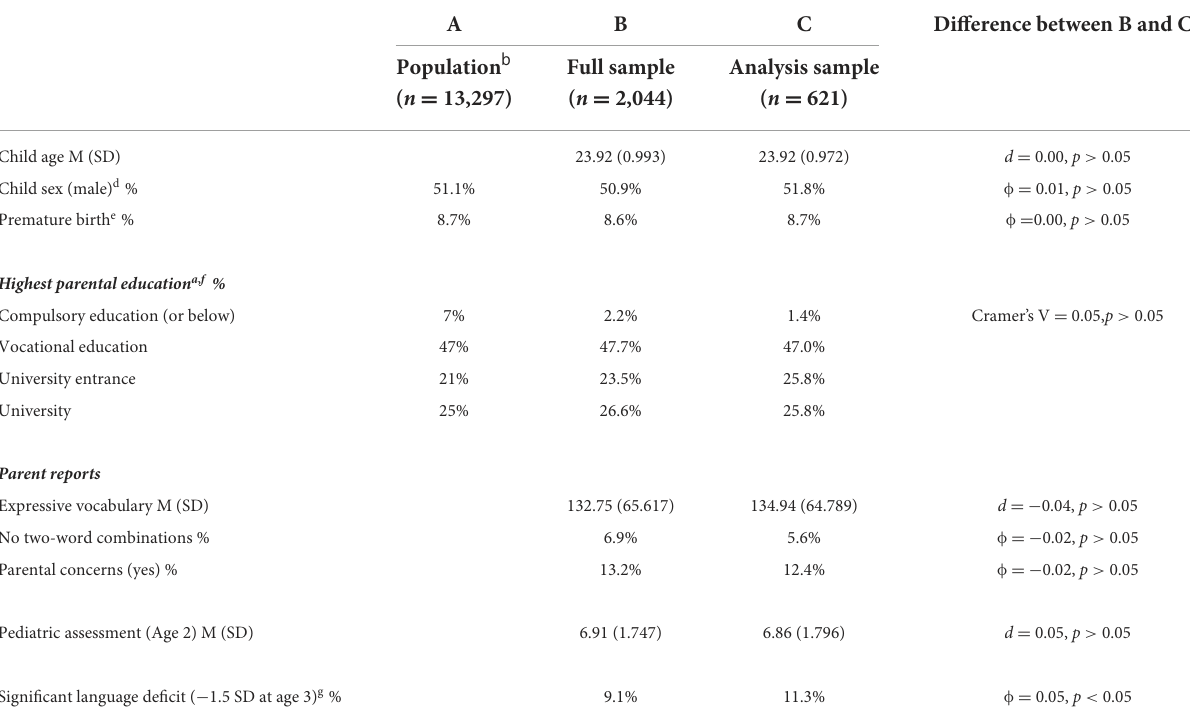
TABLE 1 Random and total sample characteristics.